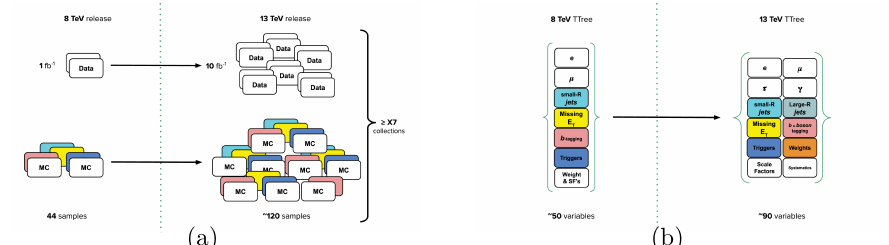
Figure 1. Evolution of ATLAS Open Data (a) dataset and (b) tuple structure from the 8 TeV release (2016) to the 13 TeV release (2020). From Ref.